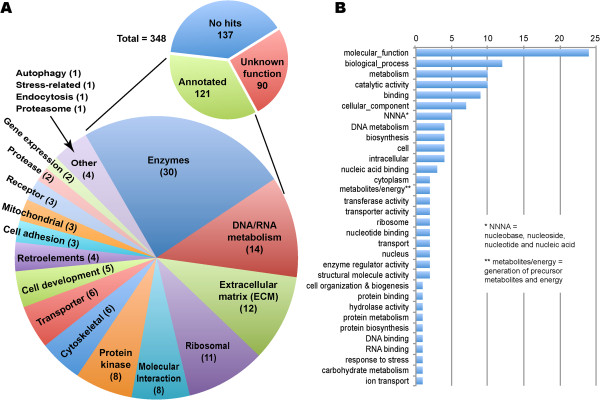
Classification of Oxyspirura petrowi genes discovered by the random genome sequence survey by major functional groups (A) or gene ontology (GO) terms (B). A list of gene contigs with annotations is provided in Additional file 1: Table S1.